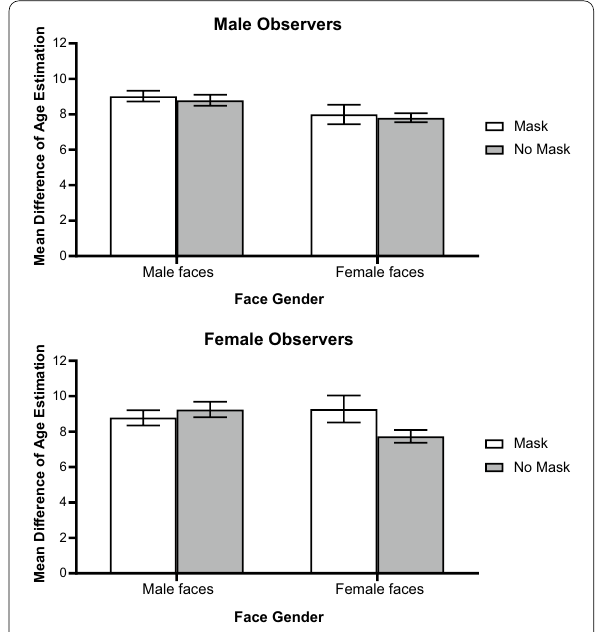
Fig. 8 The mean difference of age estimation between male and female observers on own- versus other-gender faces presented